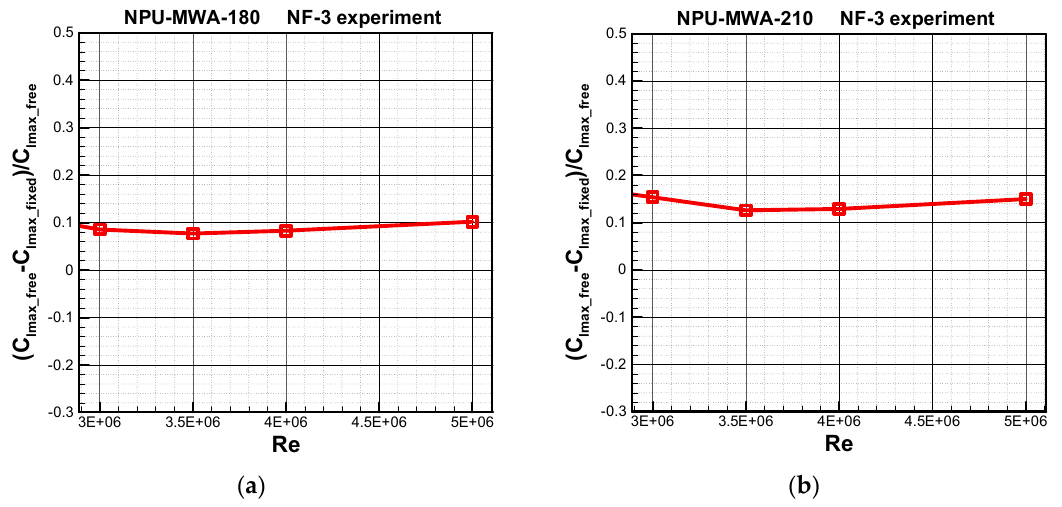
Figure 6. Sensitivity of the maximum lift coefficient to the leading edge roughness with the increase of Reynolds number (Re): ( a ) NPU-MWA-180 airfoil; ( b ) NPU-MWA-210 airfoil.